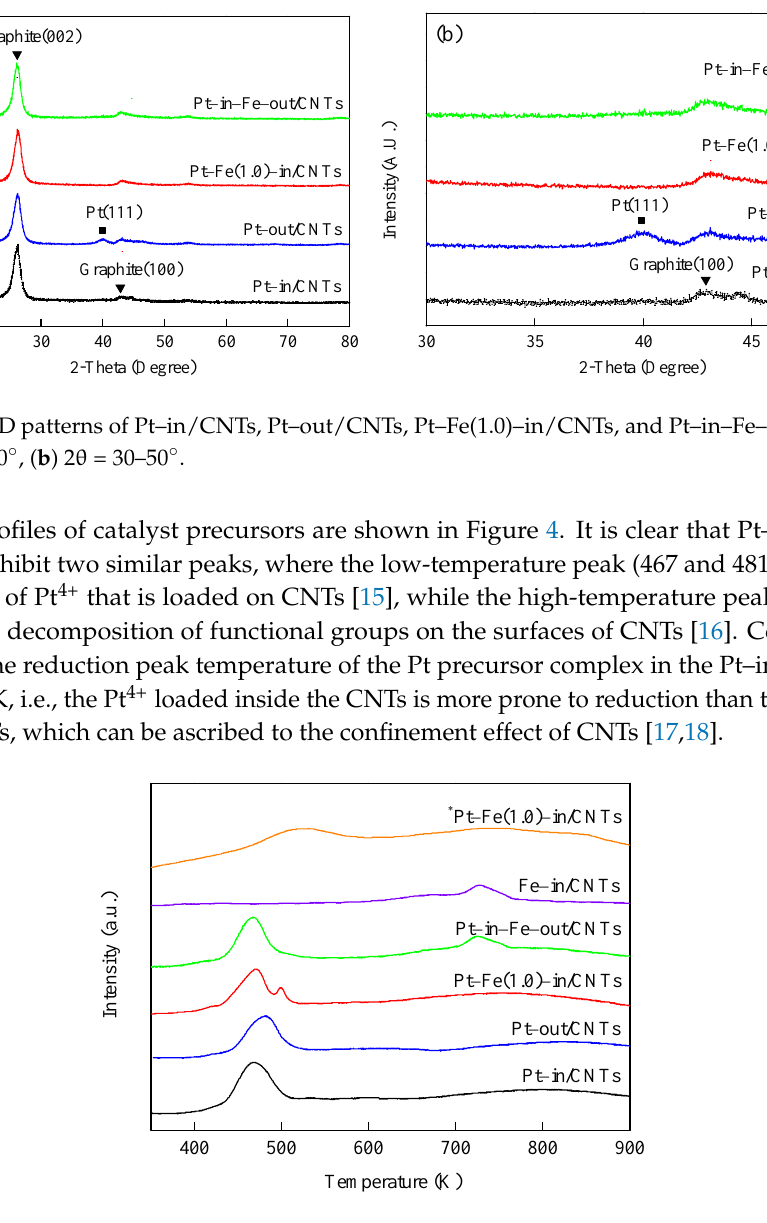
Figure 4. H 2 –TPR profiles of Pt–in/CNTs, Pt–out/CNTs, Pt–Fe(1.0)–in/CNTs, Pt–in–Fe–out/CNTs,